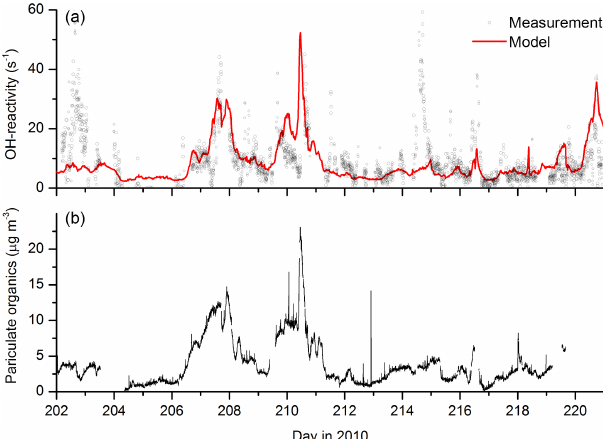
Figure 6. (a) Measured (black data points) and modelled OH re- activity (red line). The aerosol organic content (b) shows similar campaign variability to modelled OH